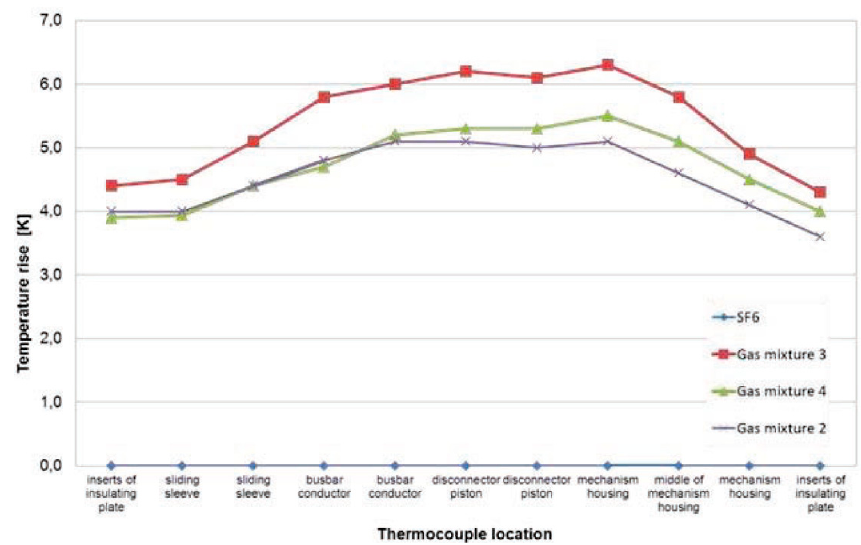
Figure 5. Temperature rise results in switchgear (GIS) filled with the Novec TM 4710/CO 2 gas mixture and sulfur hexafluoride (SF 6 ) [67].